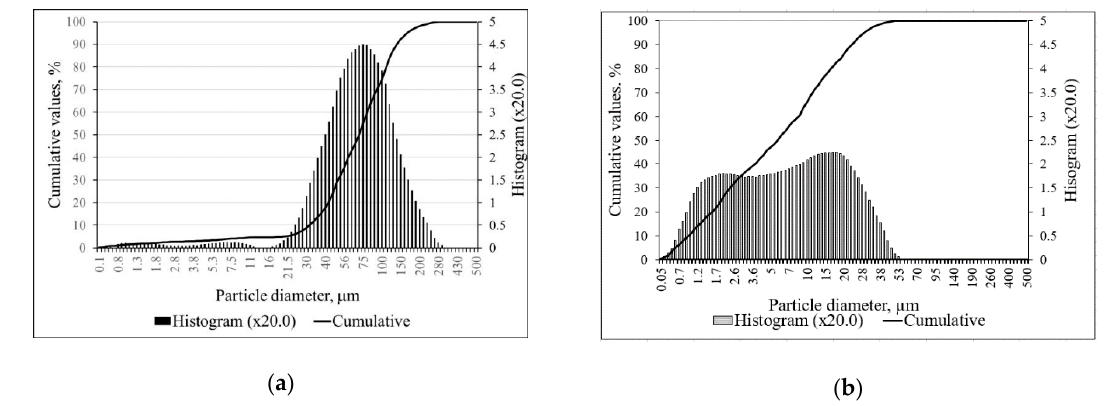
Figure 2. Particle size distributions of zeolitic by-product with ammonium chloride ( a ) and Portland cement ( b ).